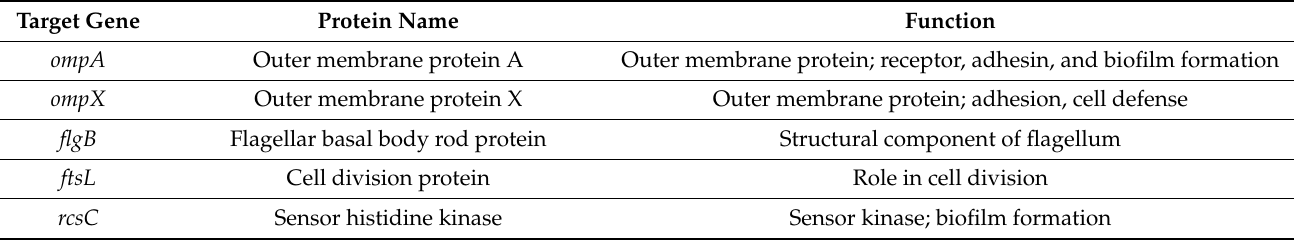
Table 1. The five target genes and their